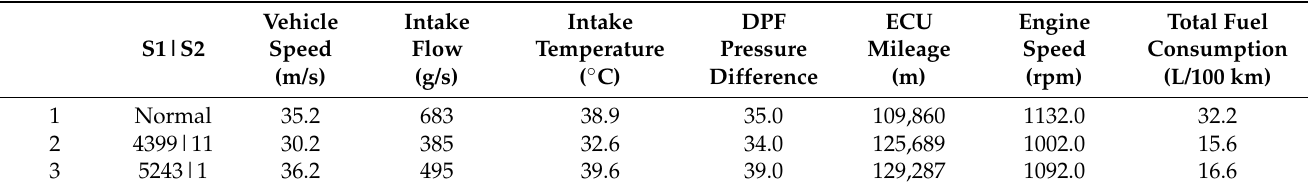
Table 2. Record samples of the data